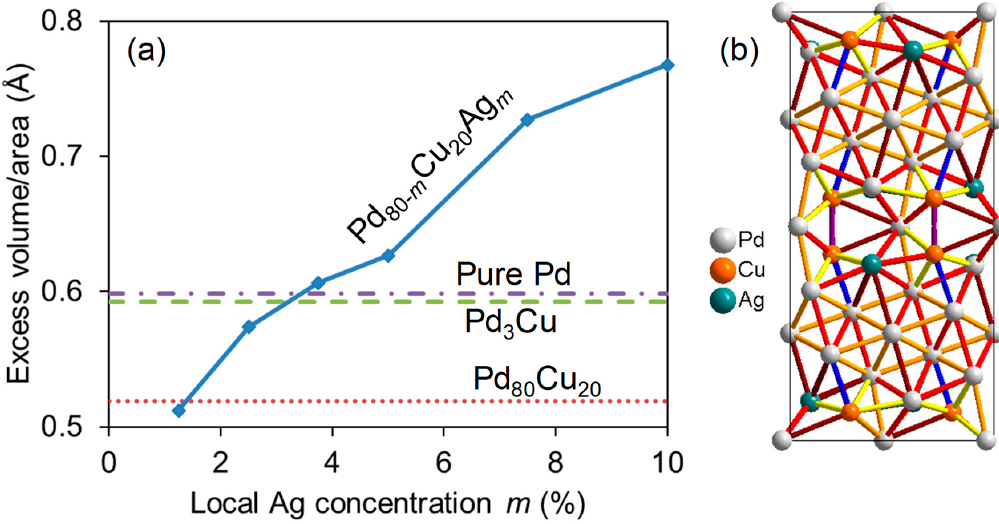
Figure 9. ( a ) The excess volume/area of an 80-atom ∑ 5(210) model (Figure 1) for pure Pd (dashed-dotted line), Pd 3 Cu (dashed), Pd 80 Cu 20 (dotted), and Pd 80 − m Cu 20 Ag m (solid). The local Ag concentration x corresponds to the concentration very close to the GB and does not necessarily reflect the overall concentration (it may have segregated towards the GB). The most stable model with m = 10% is shown in ( b ), and the interatomic distances d are indicated with rainbow colors, starting from dark red ( d > 2.9 Å) to violet ( d < 2.5 Å). The average bond distance in bulk Pd is approximately 2.7 Å, represented by yellow (2.6 < d < 2.7 Å) and orange (2.7 < d < 2.8 Å) bonds.